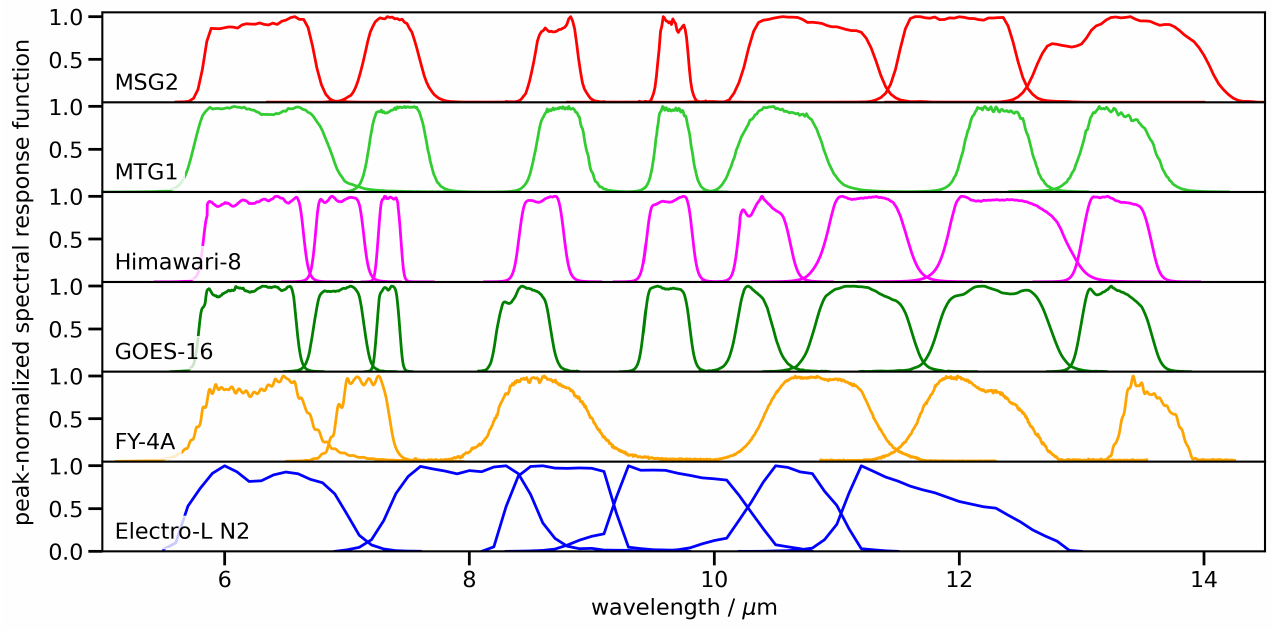
Figure 2. Peak-normalized spectral response functions of the currently active/planned, advanced imagers aboard geostationary satellites. Only channels between 5 and 15 µ m are shown. Data from [37]. Starting in 2002, four MSG satellites (MSG1 to MSG4) have been launched, named Meteosat-8 to 11. As of 3 January 2023, the current main operational satellite (MSG4) is located at 0 ◦ E. MSG3 operates at 9.5 ◦ E in rapid-scan mode, covering only the upper third of the SEVIRI disc (including Northern Africa and Europe) but at an increased temporal resolution of 5 min. MSG2 was moved to 45.5 ◦ E to cover the Indian Ocean ( Indian Ocean Data Coverage , IODC). MSG1 provided IODC until summer 2022, when it was retired